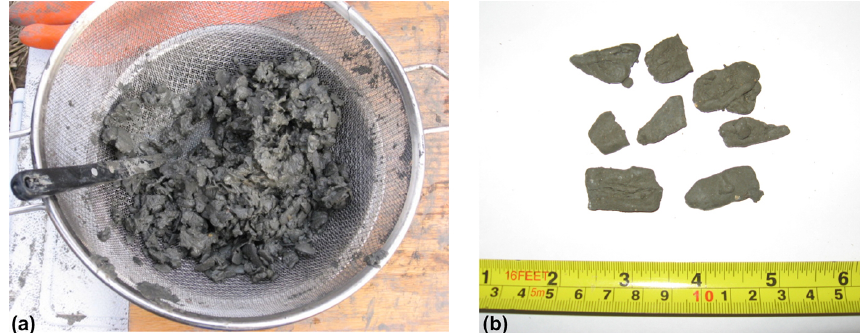
Figure 3. Evaluation of core cuttings as an alternative sample source for DVE–LS: (a) sieved chip samples after washing, and (b) wiped chip samples (typically 25 × 15mm) prior to placement in Ziploc ™